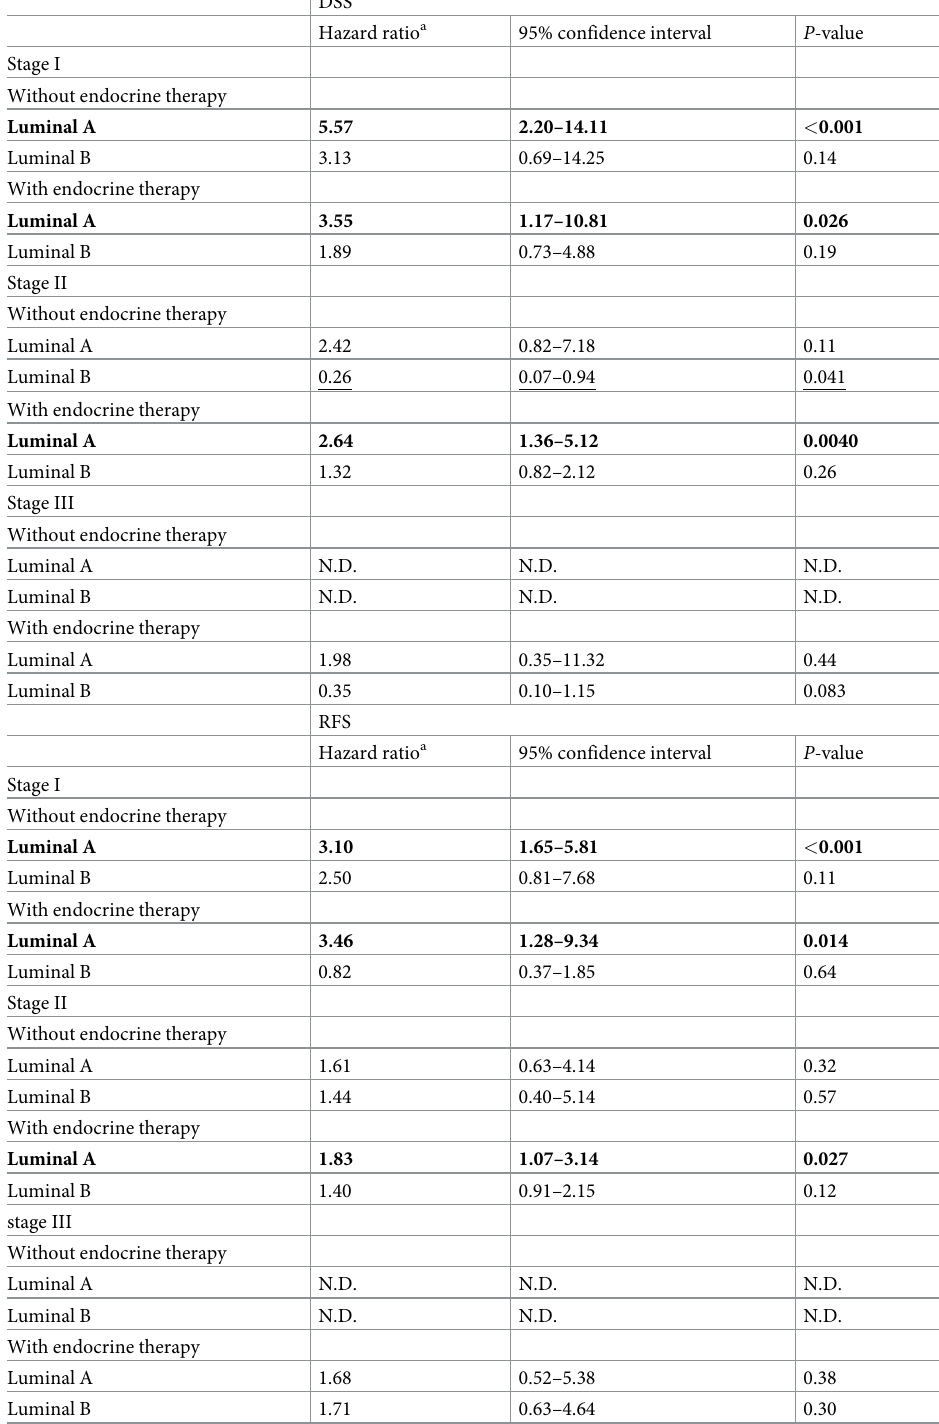
Table 4. Multivariate Cox regression analyses of disease-specific survival (DSS) and relapse-free status (RFS) in patients with luminal A and luminal B without or with endocrine therapy at various tumor stages.